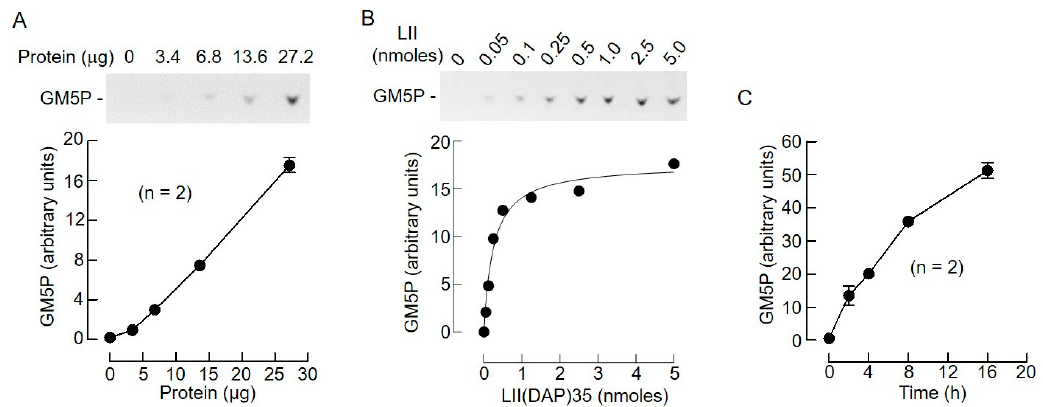
Figure 8. Biochemical characteristics of rat liver lipid II hydrolyzing activity. ( A ) LII(DAP)35 (500 pmol) was incubated with di ff erent quantities of detergent-solubilized rat liver microsomal proteins for 4 h. After SPE, the 15 mM NH 4 OH / H 2 O eluates were dried under vacuum and analyzed by TLC. The resulting fluorograms were scanned and GM5P was quantitated as described in Section 4. The means and SDs of duplicate incubations were generated using Prism software. One of the fluorograms is shown. ( B ) 27.2 µ g of detergent-solubilized rat liver microsomal proteins was incubated for 4 h with increasing quantities of LII(DAP)35, (LII nmol), and GM5P was quantitated as described above. A single experiment was performed. ( C ) LII(DAP)35 (500 pmol) was incubated with 27.2 µ g of detergent-solubilized rat liver microsomal proteins for the indicated times. GM5P was quantitated as described above.